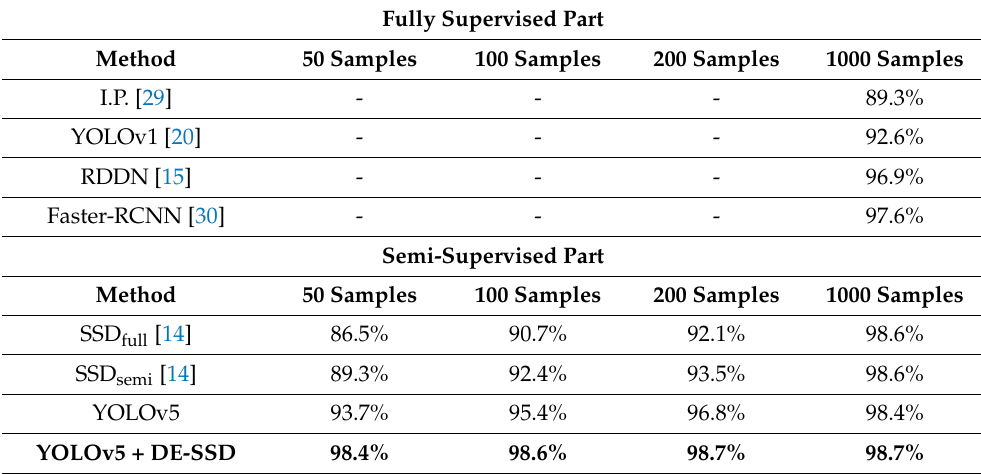
Table 1. Detailed information on experiment results.